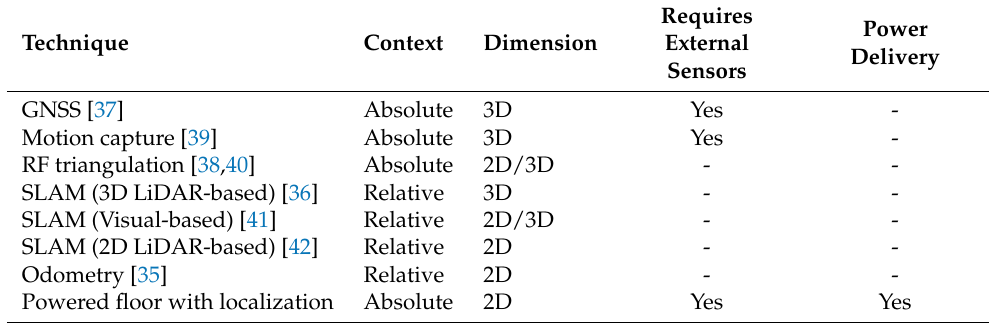
Table 1. Summary of the main robot localization